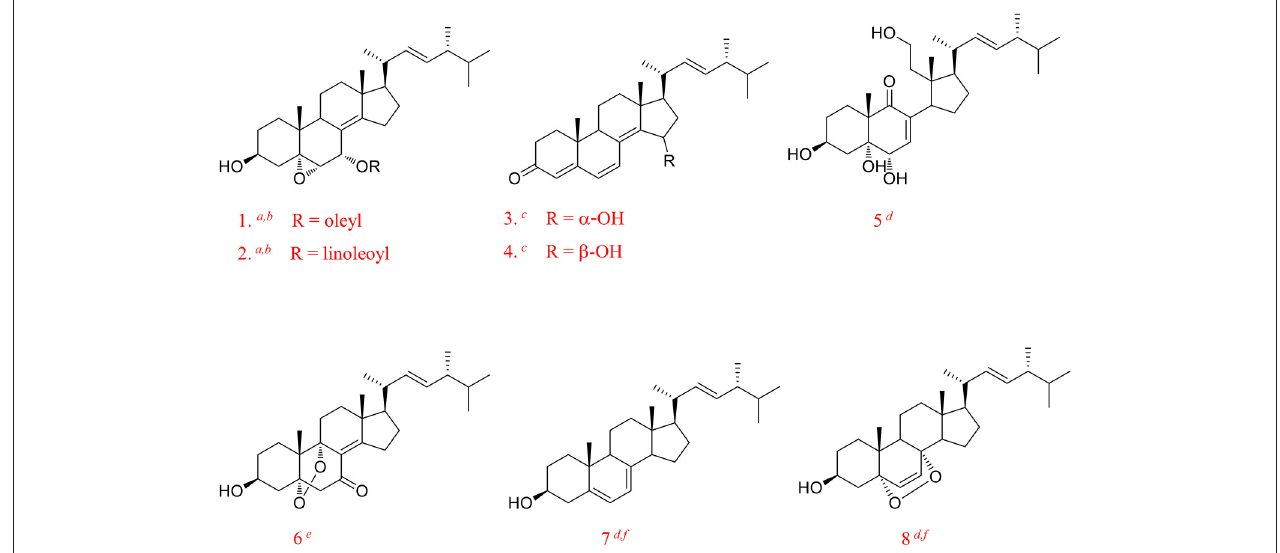
FIGURE 1 | Some of the biologically active ergosterol derivatives from common edible mushrooms from literature. (1, Erinarol A; 2, Erinarol B; 3, Ganodermaside A; 4, Ganodermaside B; 5, (22 E )-3 β , 5 α , 6 α , 11-tetrahydroxy-9(11)-seco-ergosta-7, 22-dien-9-one; 6, Gargalols B; 7, Ergosterol; 8, Ergosterol peroxide; a PPAR transactivational effect; b Cytotoxicity; c Anti-aging; d Anti-inflammatory; e Suppressing osteoclast-forming; f